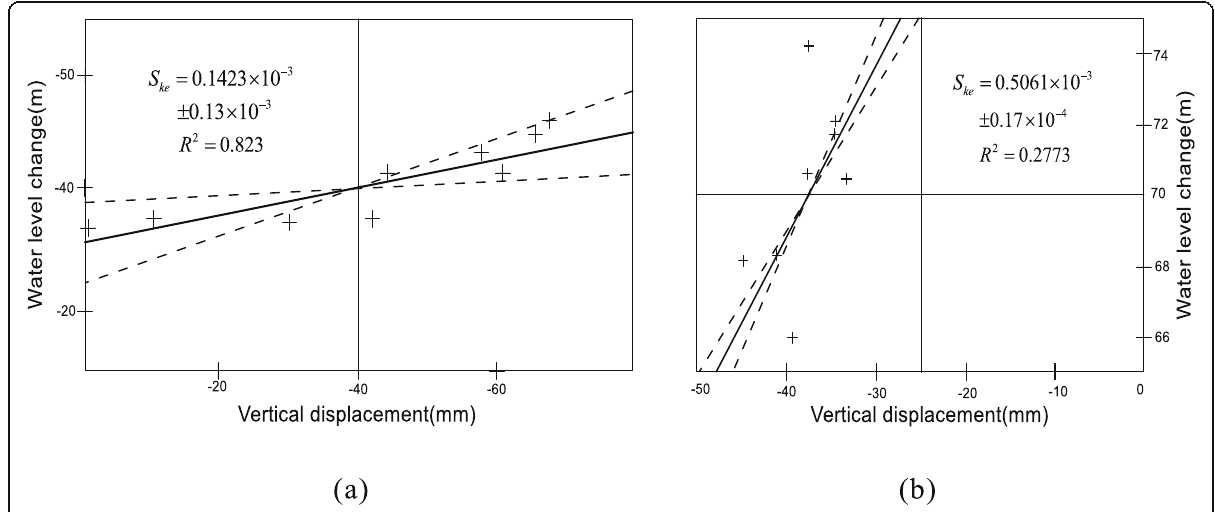
Fig. 16 Subsidence-water level change correlation diagram of water level site 4001 and 1027. As shown in this figure, the correlation between groundwater level change, ground vertical deformation, and elastic water release coefficient of water wall site 4001 ( a ) and point 1027 ( b ). The inversion line represents the best elastic release coefficient of the water level site in 2007 – 2010 by least squares fitting. Two dashed lines represent the range of fluctuations obtained by inversion of the surface deformation within an error of ±5